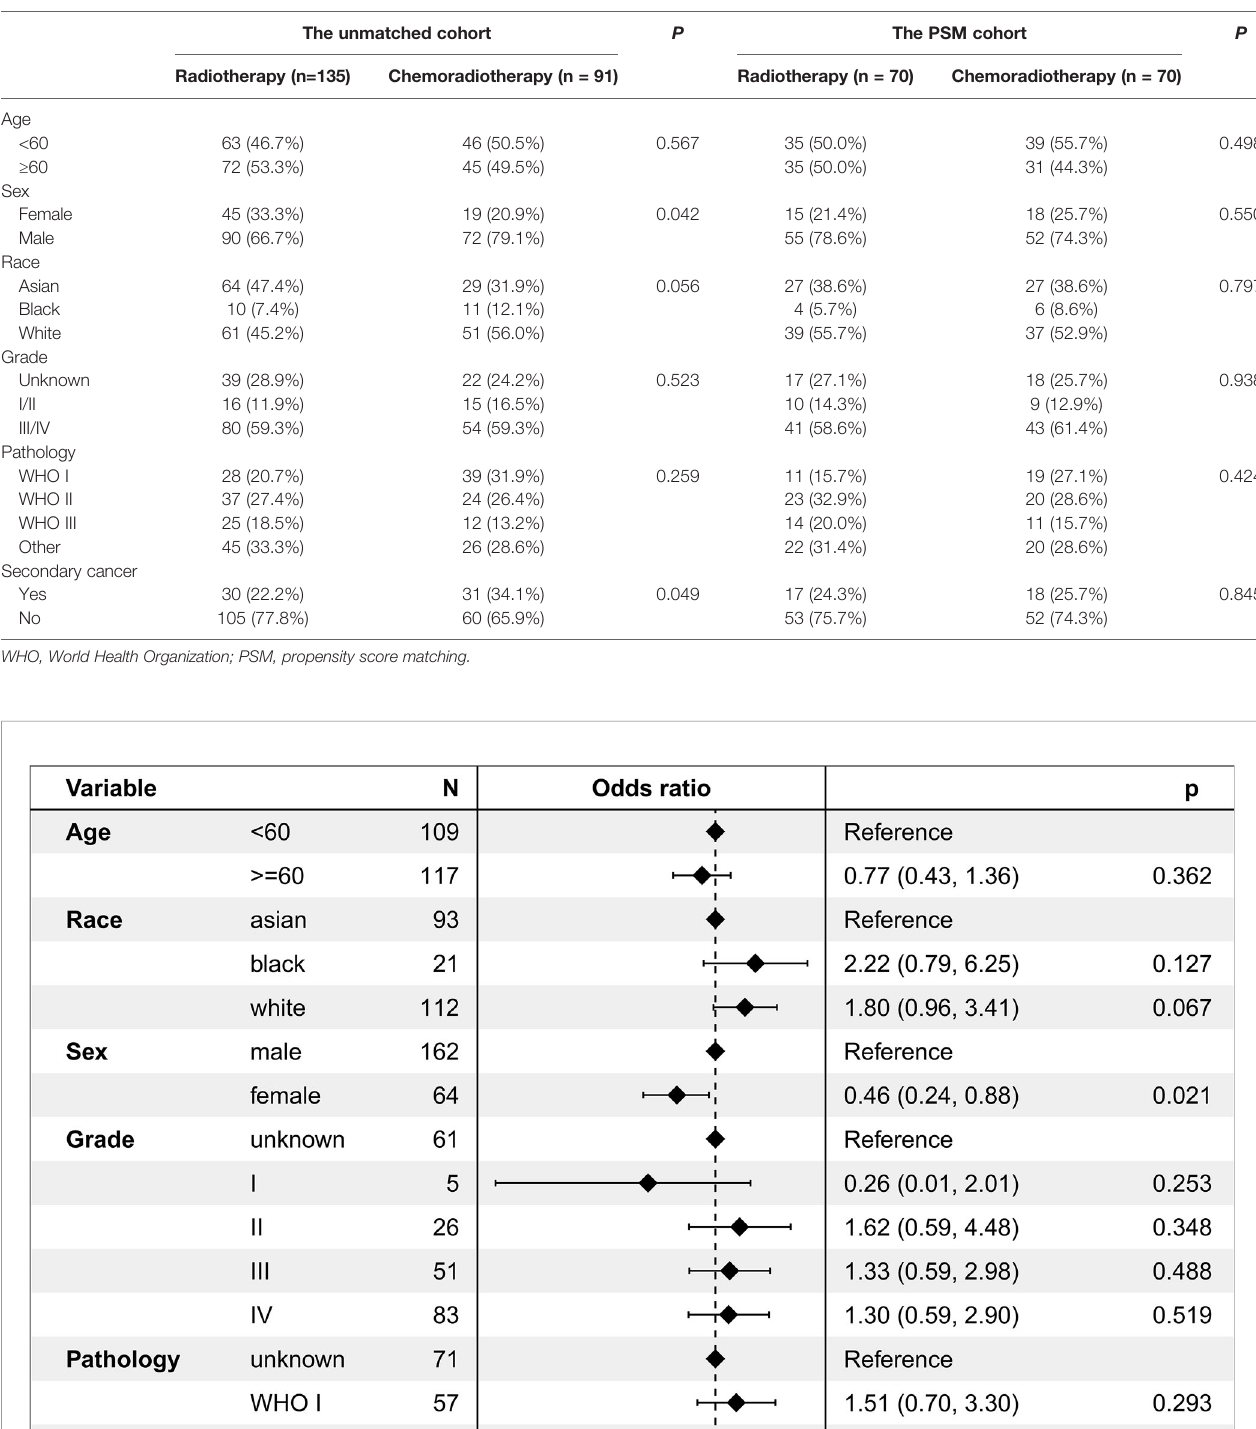
TABLE 1 | Patient characteristics.